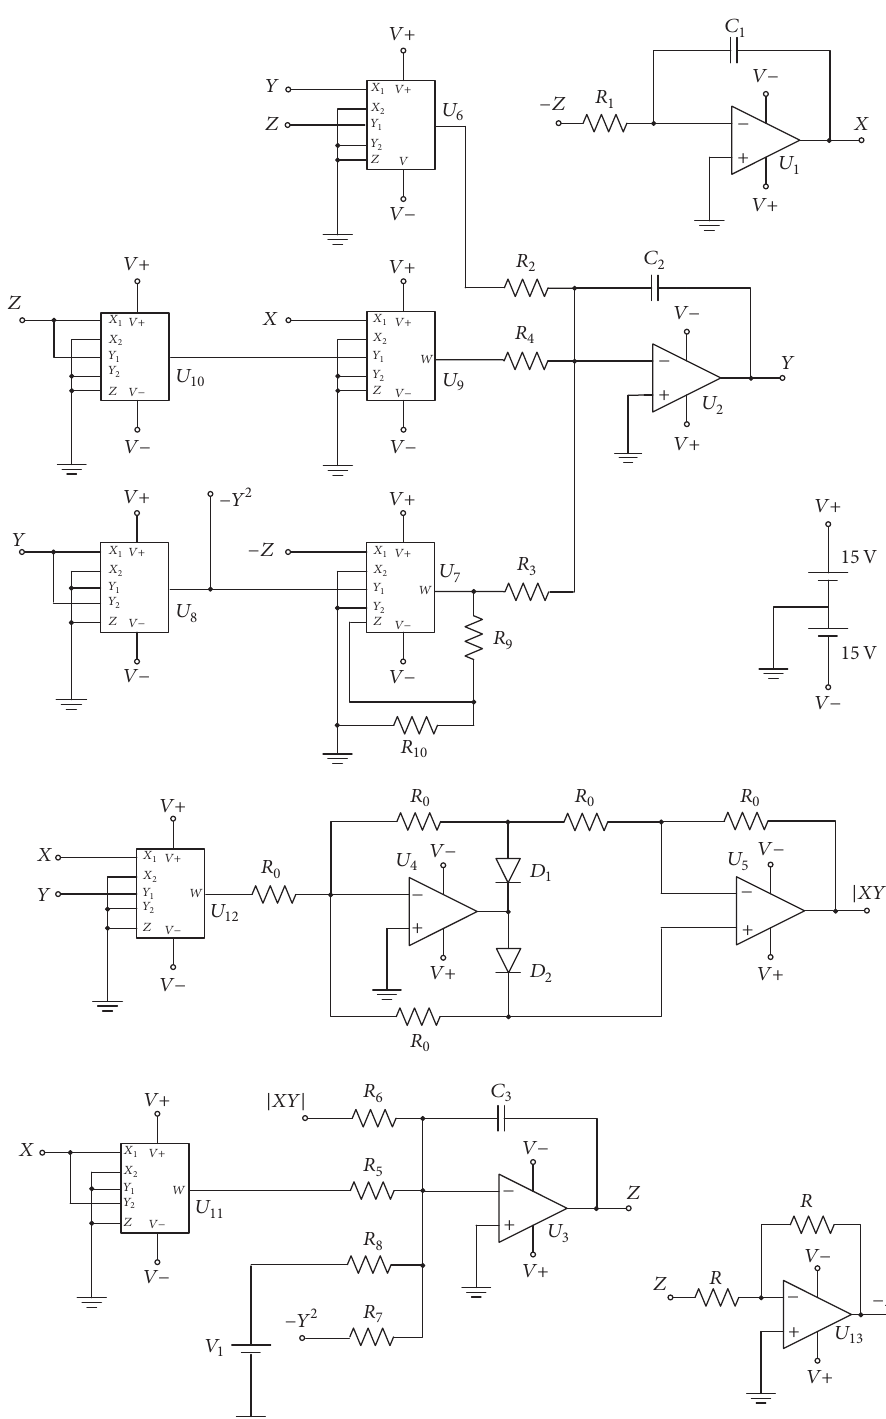
Figure 7: The schematic of the circuit which realizes the theoretical chaotic system with closed curve equilibrium (9). Here the values of three capacitors are chosen as 𝐶 1 = 𝐶 2 = 𝐶 3 = 𝐶 = 4.7